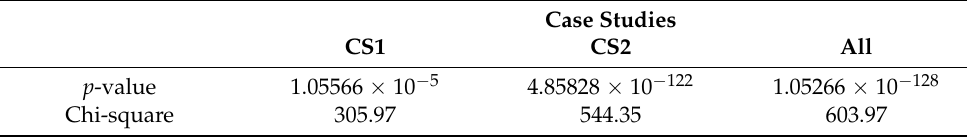
Table 8. Results of Friedman test for each case